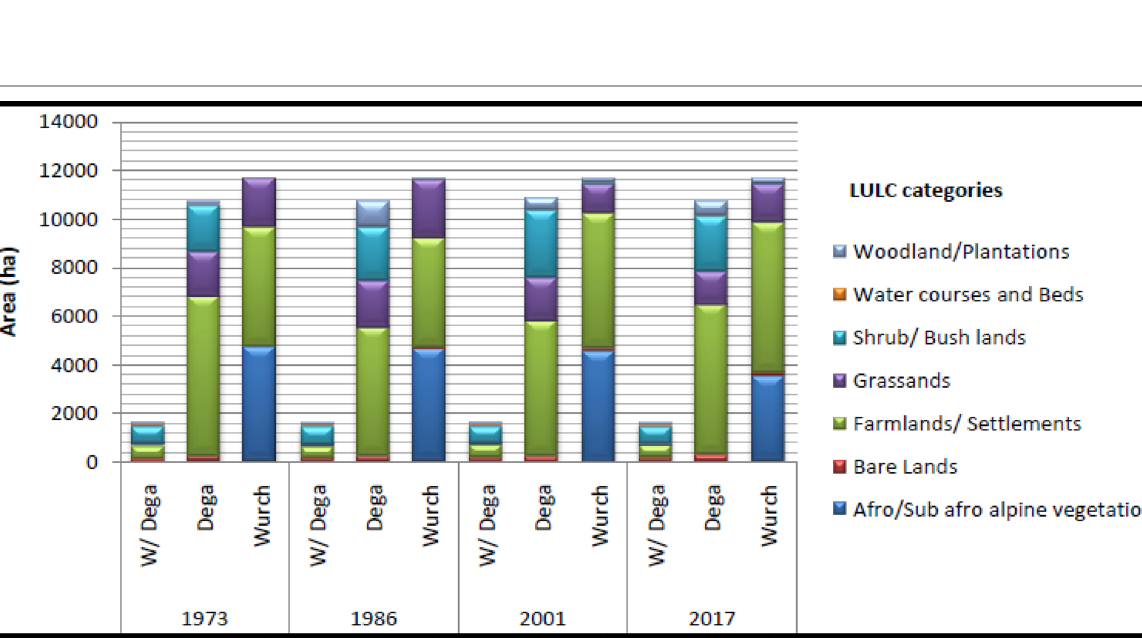
Fig. 9 Land use distribution along Agro